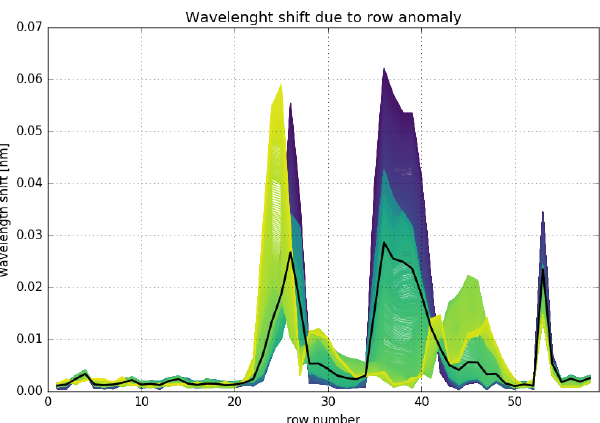
Figure 19. Radiance monitor fit wavelength shift in the VIS chan- nel obtained from orbit 50000. The data are averaged over all fit windows, and the absolute value is taken. Then for each measure- ment the moving average is determined for 100 neighboring mea- surements. The color scheme is the same as in Fig. 18. The result shows very high shift values for anomaly rows for most of the